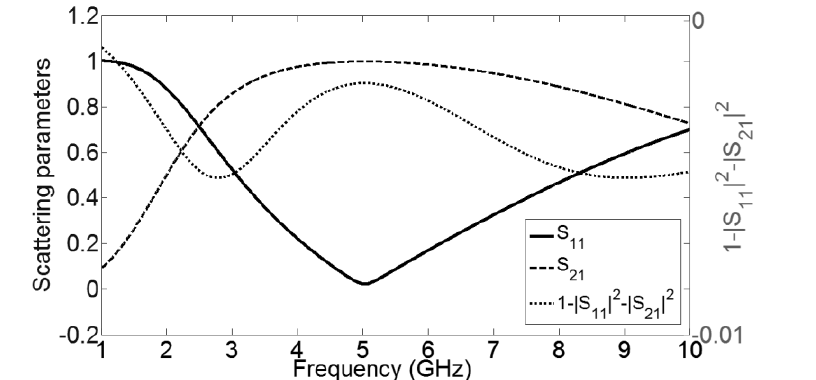
Figure 2. Scattering parameters and sign function of the active CRLH-TL unit